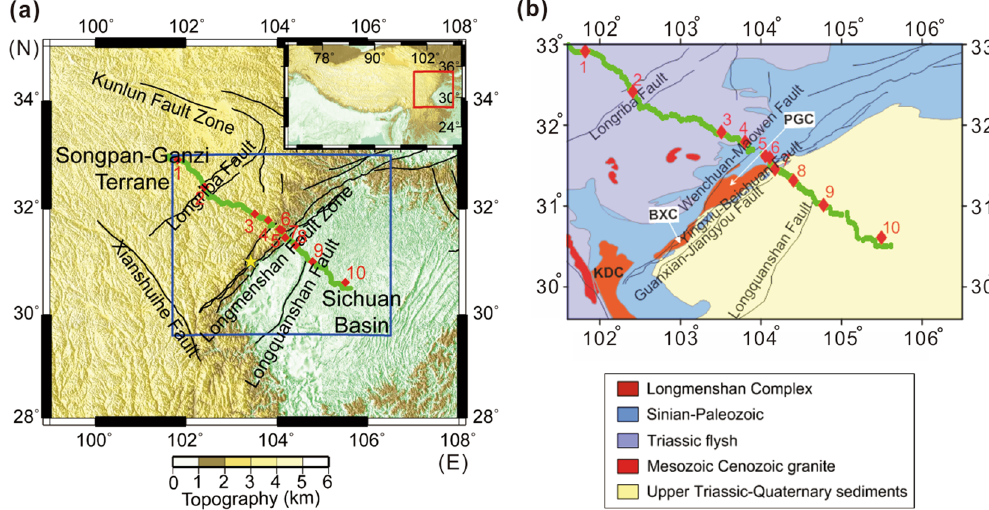
Figure 1. Tectonic and geological maps. ( a ) Tectonic map of the deep seismic sounding profile in the Eastern Tibet. Red diamonds denote shot positions (number 1, 2, … , 10), and green points denote receiver positions. Yellow star is the epicentre of Wenchuan earthquake. ( b ) Geological map to show the study area. Three Precambrian metamorphic complexes from the northeast to southwest are Pengguan complex (PGC), Baoxing complex (BXC) and Kangding complex (KDC). The blue rectangular box in ( a ) indicates the range of the geological map shown in ( b ). Maps are created using GMT (Generic Mapping Tools, http://gmt.soest.hawaii. edu/)